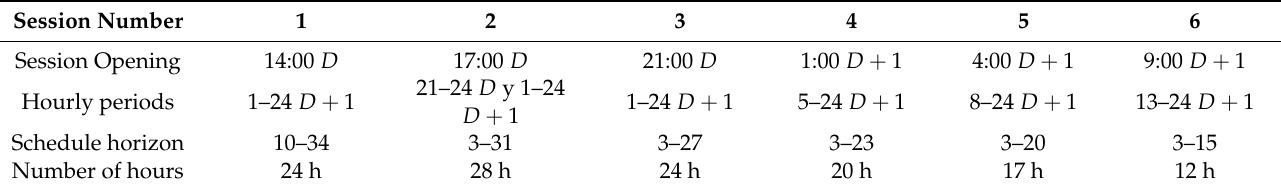
Table 2. Spanish intraday market structure